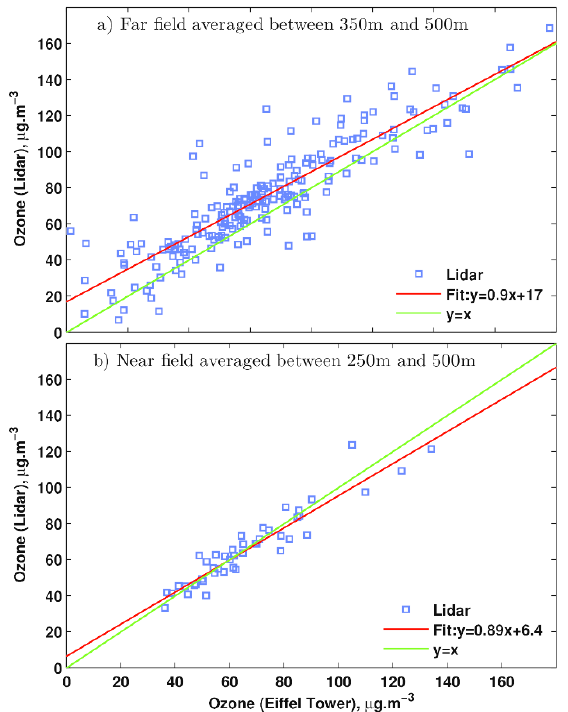
Fig. 1: Scatter plot of ozone concentrations meas- ured by the Lidar and the Eiffel Tower meas- urements between 2011 and 2014. Top panel shows the Lidar far field (large telescope) aver- aged between 350m and 500m and the bottom panel shows the Lidar near field (small telescope) averaged between 250m and